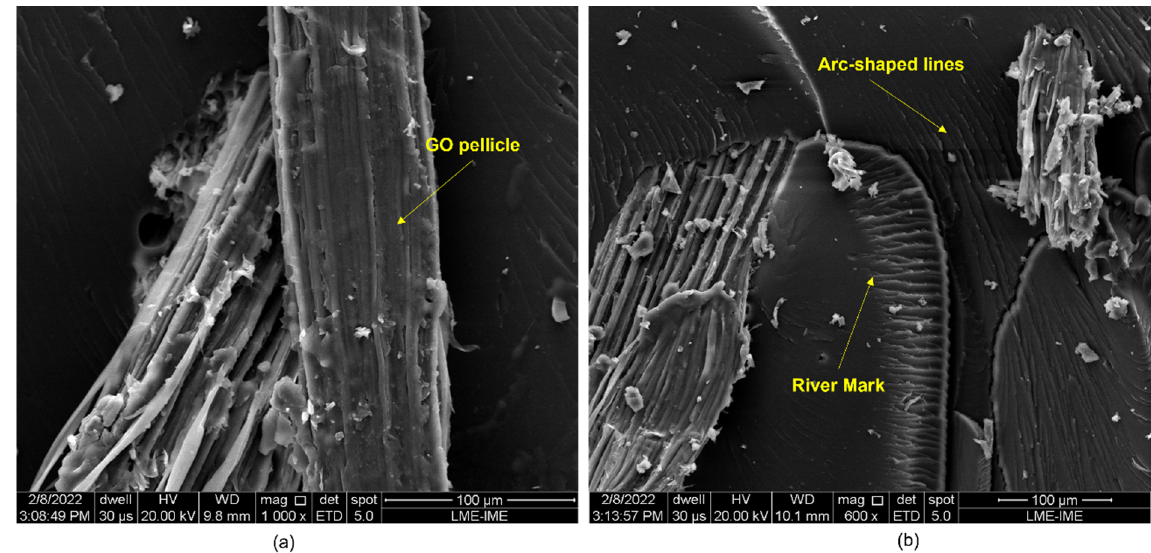
Figure 12. Fracture surface of a bidirectional composite with 30 vol.% fibers (PGO/EGO) at 1000× ( a ) and 600× ( b ) magnifications.